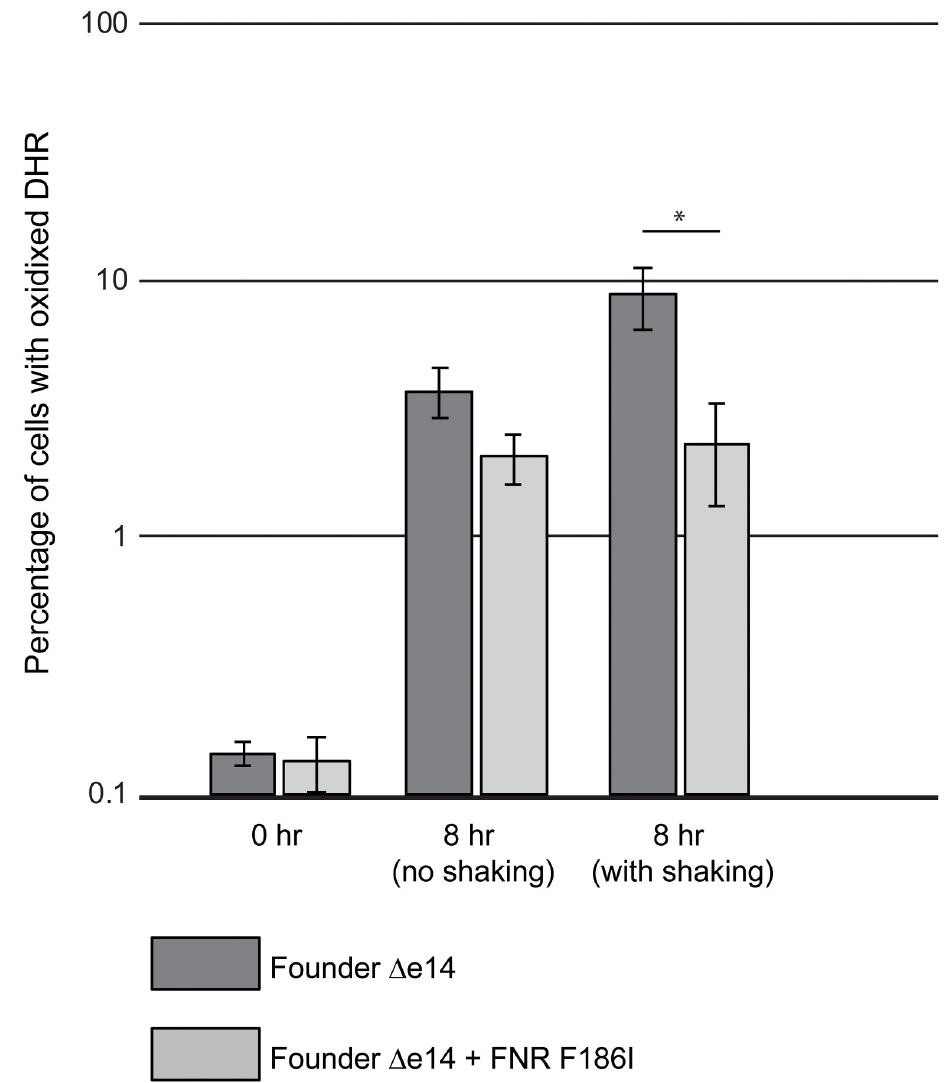
Fig 4. The FNR F186I reduces oxidation of the fluorescent dye dihydrorhodamine-1,2,3. Founder Δ e14 + FNR F186I has reduced levels of oxidized DHR in mock-IR conditions with and without shaking compared to Founder Δ e14. These data represent a single, representative experiment conducted with biological triplicate of each strain. Experiments were carried out as described in the Materials and Methods. Statistical significance was determined using a two-tailed Student’s t-test. P-values are indicated using the ‘ � ’ (p < 0.05) symbol. Data for these experiments are contained in the Supporting Information (S4 File. Oxidized DHR data).